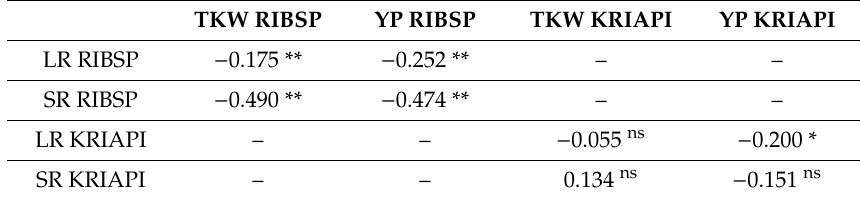
Table 6. Correlations between leaf rust (LR) and stem rust (SR) resistance at the adult plant stage and yield-related traits in the Pamyati Azieva × Paragon mapping